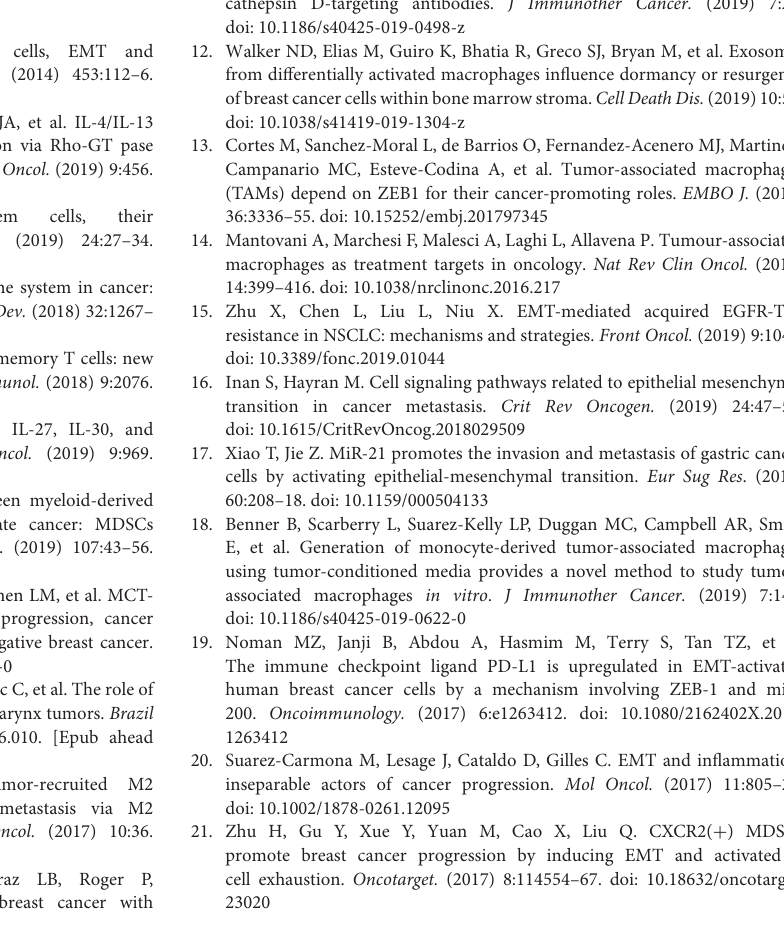
Supplementary Figure 1 | The ROC analysis of CANX to detect the metastatic from non-metastatic stages of breast cancer patients. The AUC of CANX was 1 ( p <